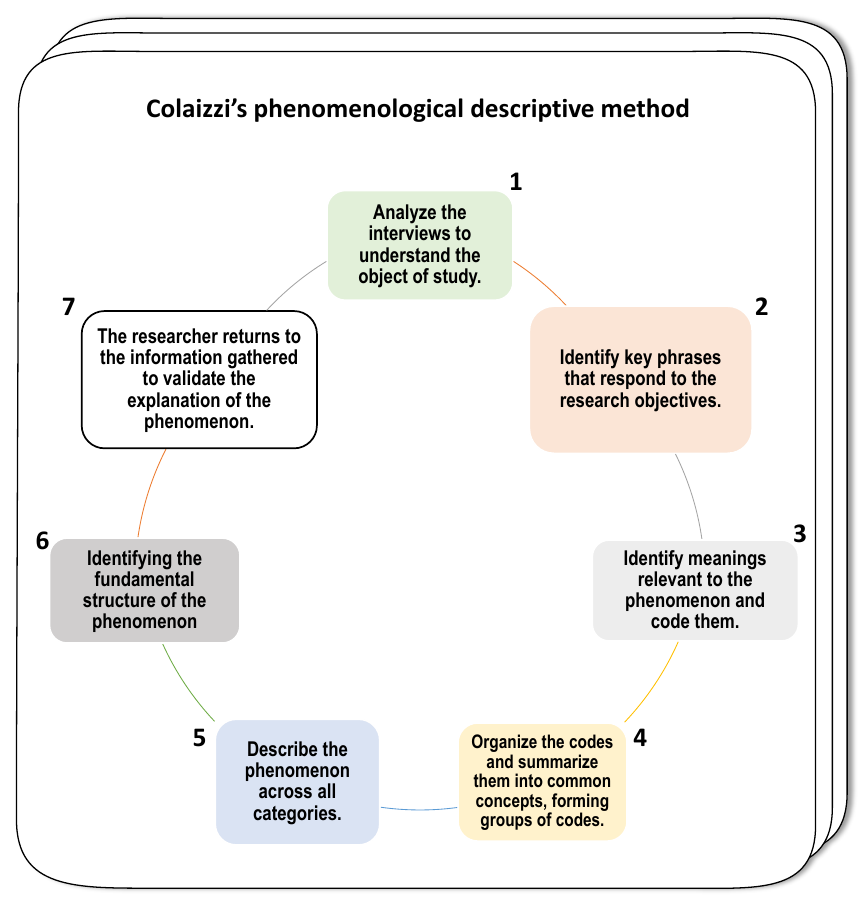
Figure 1. Colaizzi’s descriptive phenomenological